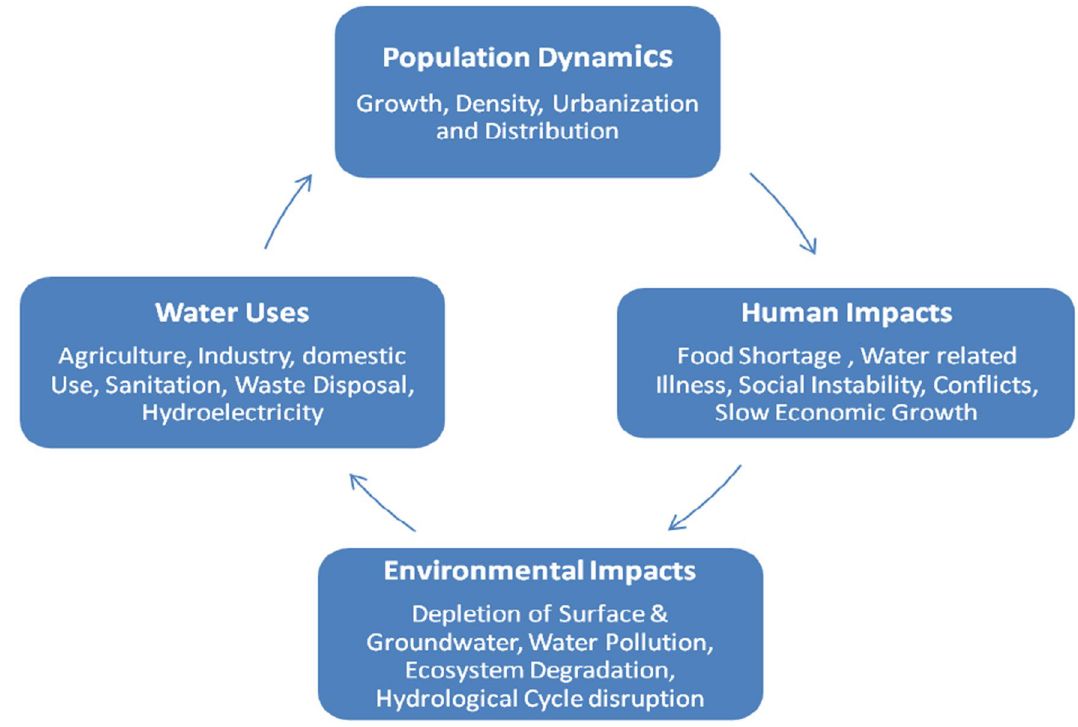
Fig. 1 Dynamics of population, human health and freshwater impacts Adapted from Gleick